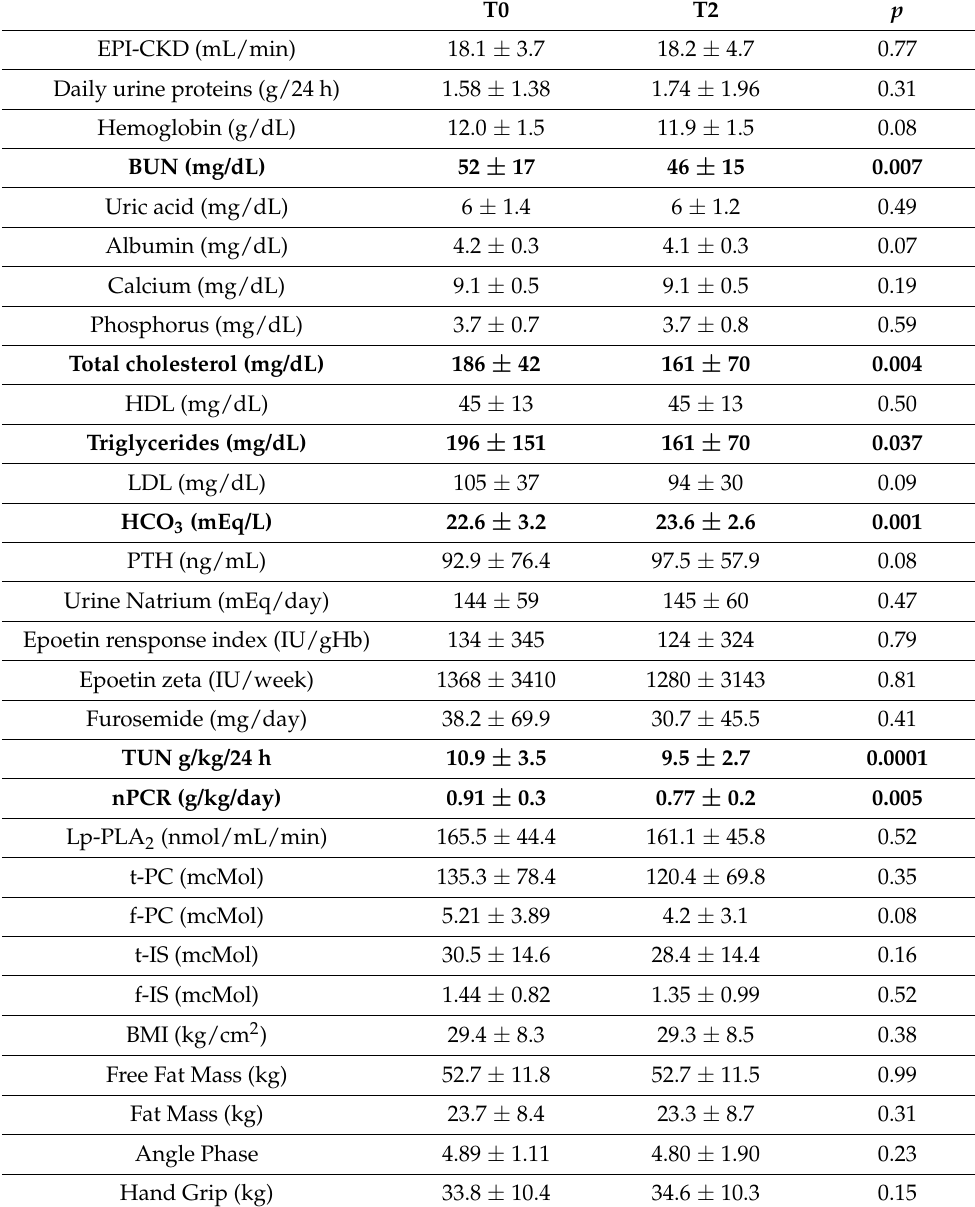
Table 1. Comparison between biochemical and nutritional parameters and pharmacological therapy in all